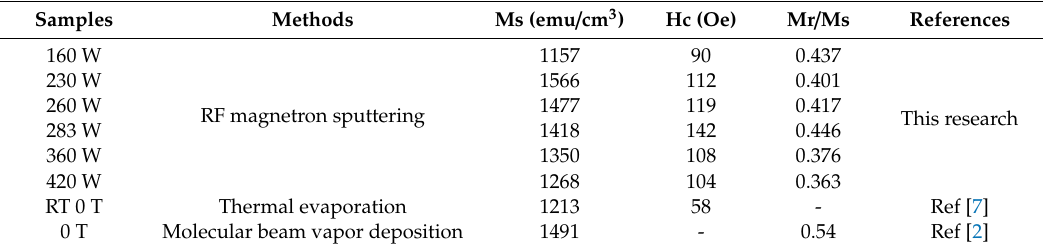
Table 1. Magnetic properties of iron thin films under di ff erent preparation